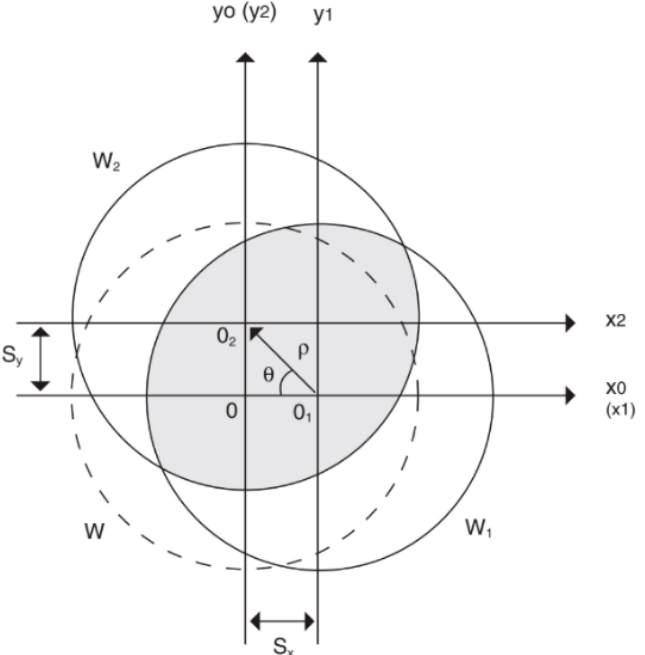
(in a grey color) of the two sheared wavefronts. S x and S y are the amount of shear in the x and y directions, respectively; r is the shear vector, and q is the shear angle.